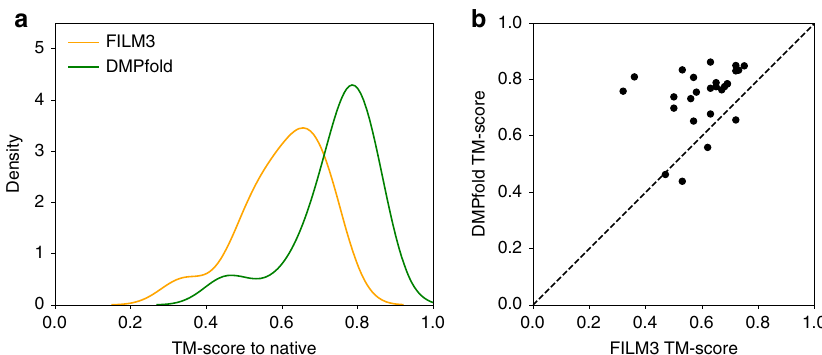
Fig. 3 Performance of DMPfold on transmembrane proteins. a Distribution of TM-scores for the FILM3 TMP dataset. One model is generated for each of the 28 proteins. The FILM3 results are the fi nal re fi ned models from the FILM3 paper 25 . b The per-protein correlation of TM-scores. The dashed line indicates the point of equal quality models between the two methods